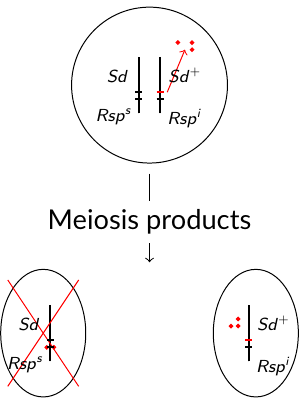
Figure 2 – Figure simplified from Bravo Núnez et al. (2018). An example of segregation distortion of meiotic gene drivers with the “killer-target" strategy is shown for the SD gene complex in Drosophila melanogaster . This complex involves the Sd and Rsp loci. The “target" locus Rsp harbours two alleles: the Rsp s and Rsp i that are respectively sensitive and insensitive to the meiotic driver. Sd produces a “killer" element (red dots, a protein in this example) which interferes with Rsp s and kills the meiotic products that inherit Rsp s